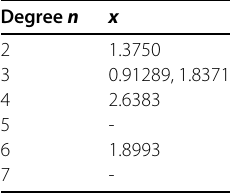
Table 3 Approximate solutions of T ( k ) n , q ( x ) = 0, k = –3, q =